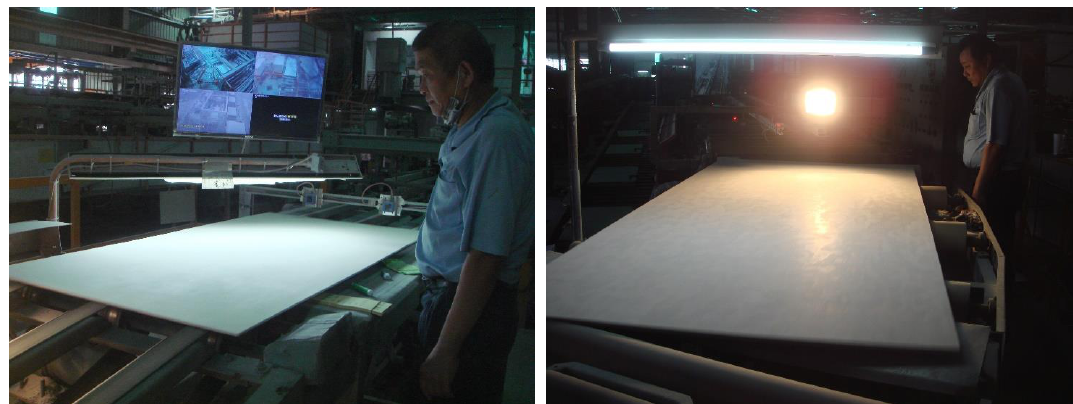
Figure 1. Manual inspection for surface defect detection of calcium silicate boards.